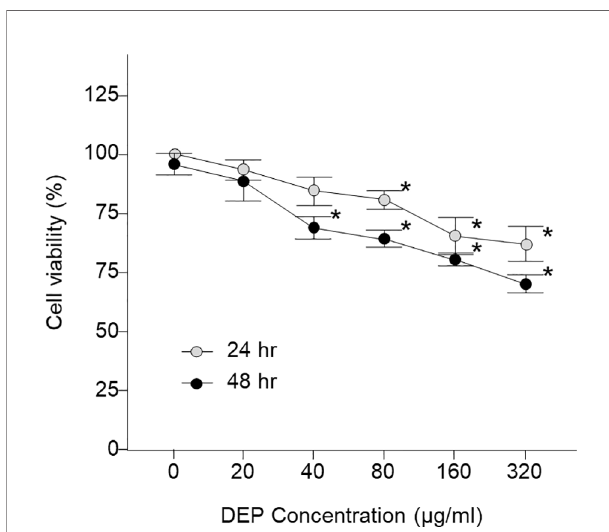
FIGURE 1 | Viability of LPS- and DEP-exposed HMEECs assessed by the CCK-8 assay and study design of the in vitro model. LPS and DEP exposure decreased cell viability in HMEECs. *p<0.05 compared with the 24 hr and 48 hr normal control groups. LPS, lipopolysaccharide; DEP, diesel exhaust particles; HMEECs, human middle ear epithelial